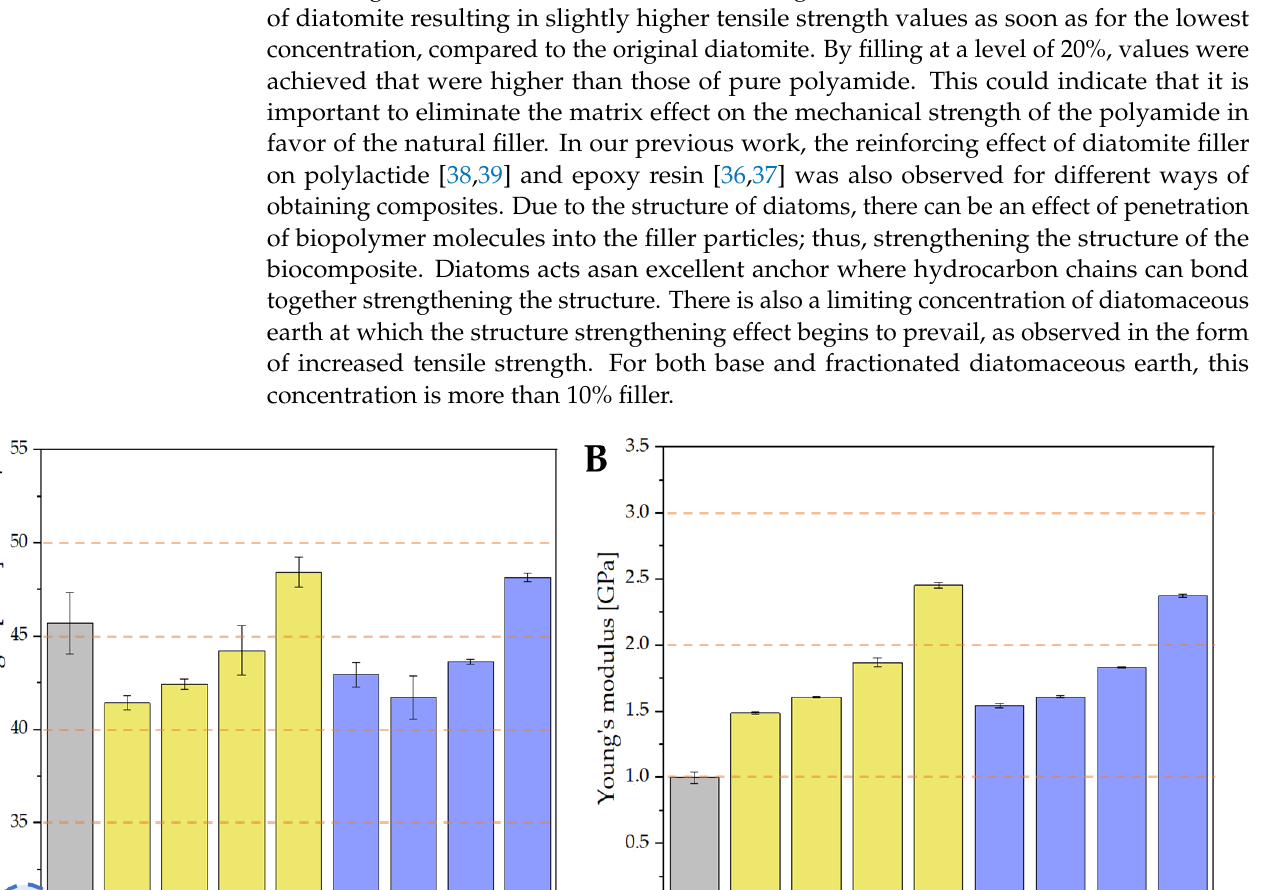
Figure 10. The results of static flexural strength test: maximum bending stress and modulus of elasticity.